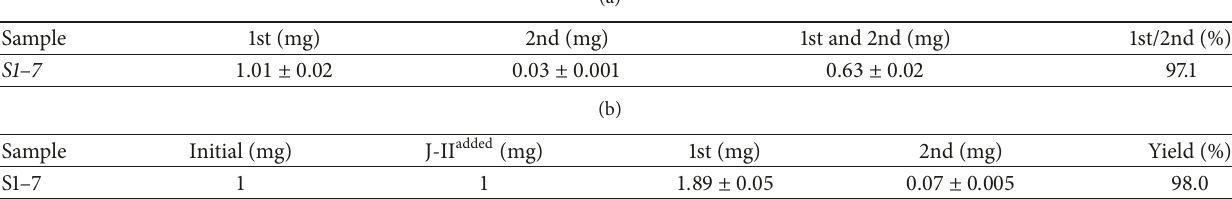
Table 2: (a) The amounts of javamide-II in 1st and 2nd extractions. The mixture of seven green coffee extract samples (S1–S7) as described in Table 1 was extracted twice with 70% MeOH (50 mL), providing the 1st and 2nd extracts. The amounts of javamide-II were presented as mg per 1g green coffee sample ( 𝑛 = 5 ). (b) The recovery yield of javamide-II. The purified javamide-II (1mg) was added to the mixture of the seven green coffee extract sample containing 1mg javamide-II and extracted with 70% MeOH. The recovery was determined using 1st and 2nd extracts ( 𝑛 = 5 ).